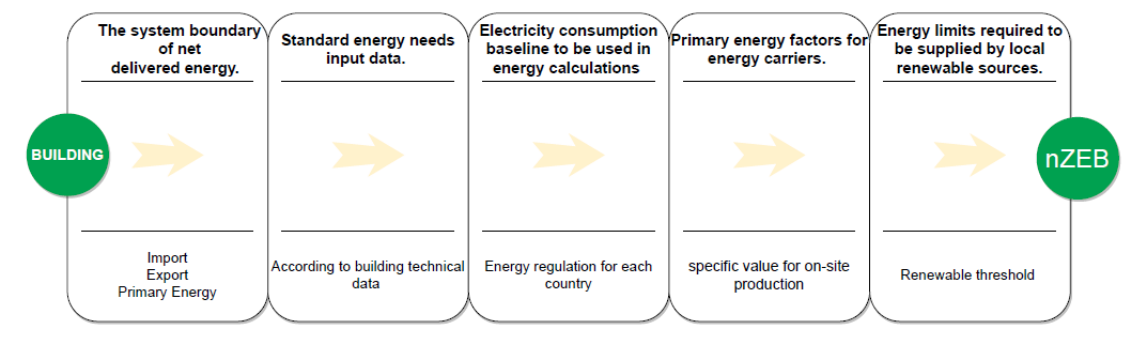
Figure 9. The procedure to define the energy limits for nZEB in Panama.